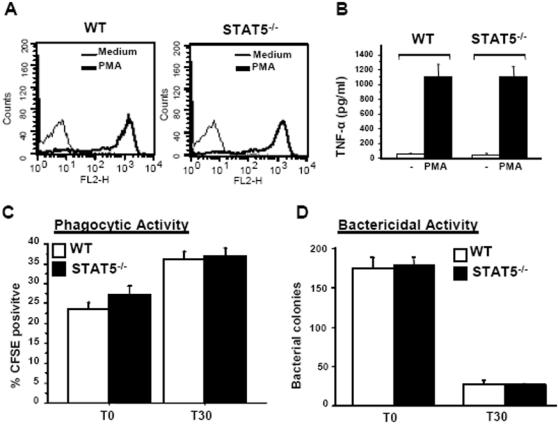
Peripheral STAT5−/− neutrophils are functional.(A) Peritoneal neutrophils from TGA-treated wild-type (WT) or STAT5−/− mice were analyzed for oxidation of dihydrorhodamine to fluorescent rhodamine by FACS with or without treatment with PMA (1 µg/ml). (B) STAT5−/− neutrophils are able to produce TNF-α. 1×106 peritoneal neutrophils from control or mutant mice were stimulated for 6 h with PMA (1 µg/ml), and TNF-α concentration in cell supernatants was then measured by ELISA. (C) STAT5−/− neutrophils are phagocytic. CFSE-labeled Staphylococcus aureus were incubated with peritoneal neutrophils at 37°C for 30 min (T0), and gentamycin was added for an additional 30 min (T30). Cells washed free of extracellular bacteria at T0 or T30 min were analyzed by FACS for engulfed bacteria. (D) STAT5−/− neutrophils are bactericidal. Engulfed bacteria were released by lysing peritoneal neutrophils in 1 ml water. One hundred microliters of a 1:1,000 dilution of the bacterial suspension was plated and colonies were counted after a 24-h incubation at 37°C.